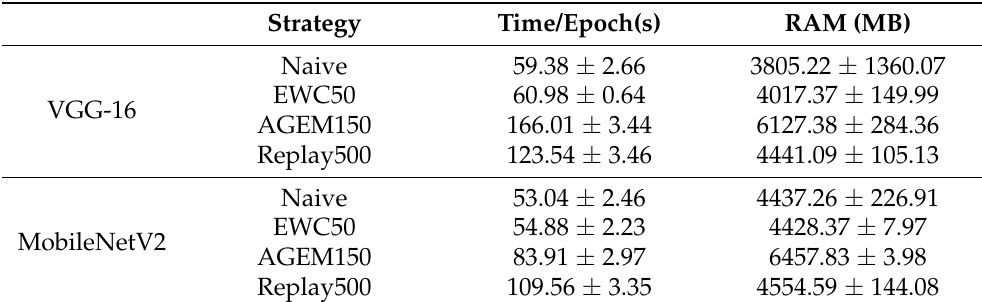
Table 8. Training results in terms of efficiency concerning the best approaches for the two models. Results averaged over 10 iterations ( ± SD).